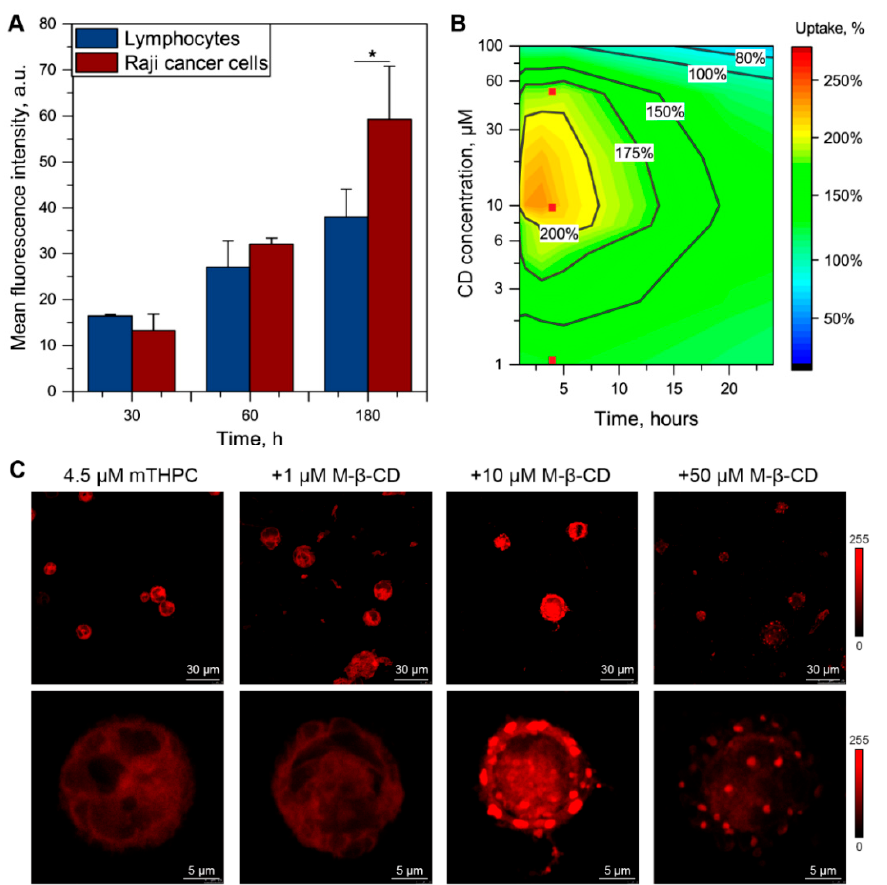
Figure 6. Alteration of mTHPC uptake in Raji cells in the presence of Me- β -CD. ( A ) Uptake of mTHPC in patient-derived lymphocytes ( █ ) and Raji ( █ ) cancer cells after 0.5-h, 1-h and 3-h incubation. Graphs represent the mean ± SD ( n = 3; * p < 0.05, using two-sample t-test). ( B ) The 2D contour plot of mTHPC uptake in Raji as the function of time and concentration of Me- β -CD. Uptake of mTHPC in the absence of Me- β -CD was taken as 100%. Red dots ( ■ ) correspond to the conditions chosen for microscopy analysis. ( C ) The typical fluorescence images of Raji cells exposed to mTHPC for 3 h in the absence/presence of various Me- β -CD concentrations; ×40 air objective and ×63 oil immersion objective. High-magnification images display the surface of the cells. The concentration of mTHPC was 4.5 µM. Serum concentration was 2%.